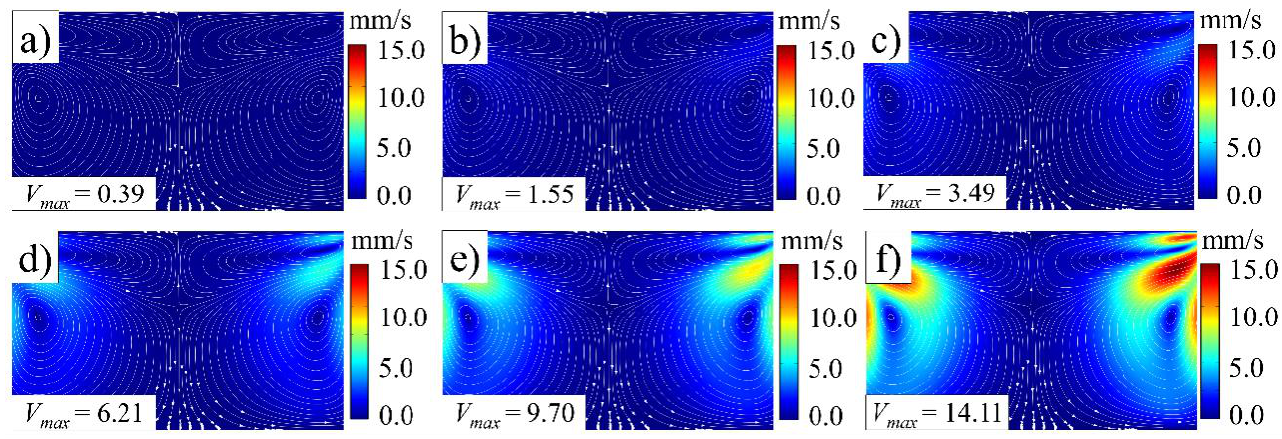
Figure 8. Melt stream velocity distribution under various ultrasonic amplitudes (ultrasonic frequency,